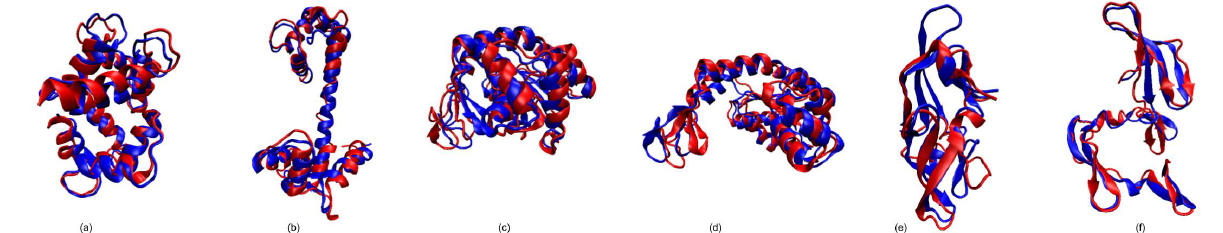
Figure 3. Superimposition of the simulated structure (red) and the original structure (blue). ( a ) 1 CTR , ( b ) 1 CLL , ( c ) 1 AKE ,